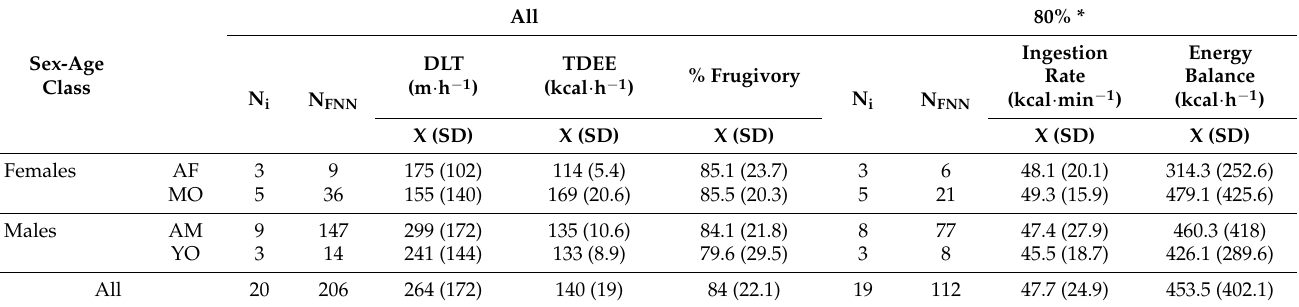
Figure 4. Activity budget of the Sebitoli community according to sex–age classes. AF: non-maternal females; MO: mothers; AM: adult males; YO: subadult males. Values represent the mean value of each activity per class. Table 6. Contribution of sex–age classes in daily paths, energy balance, and frugivory between January 2016 and January 2019, all seasons